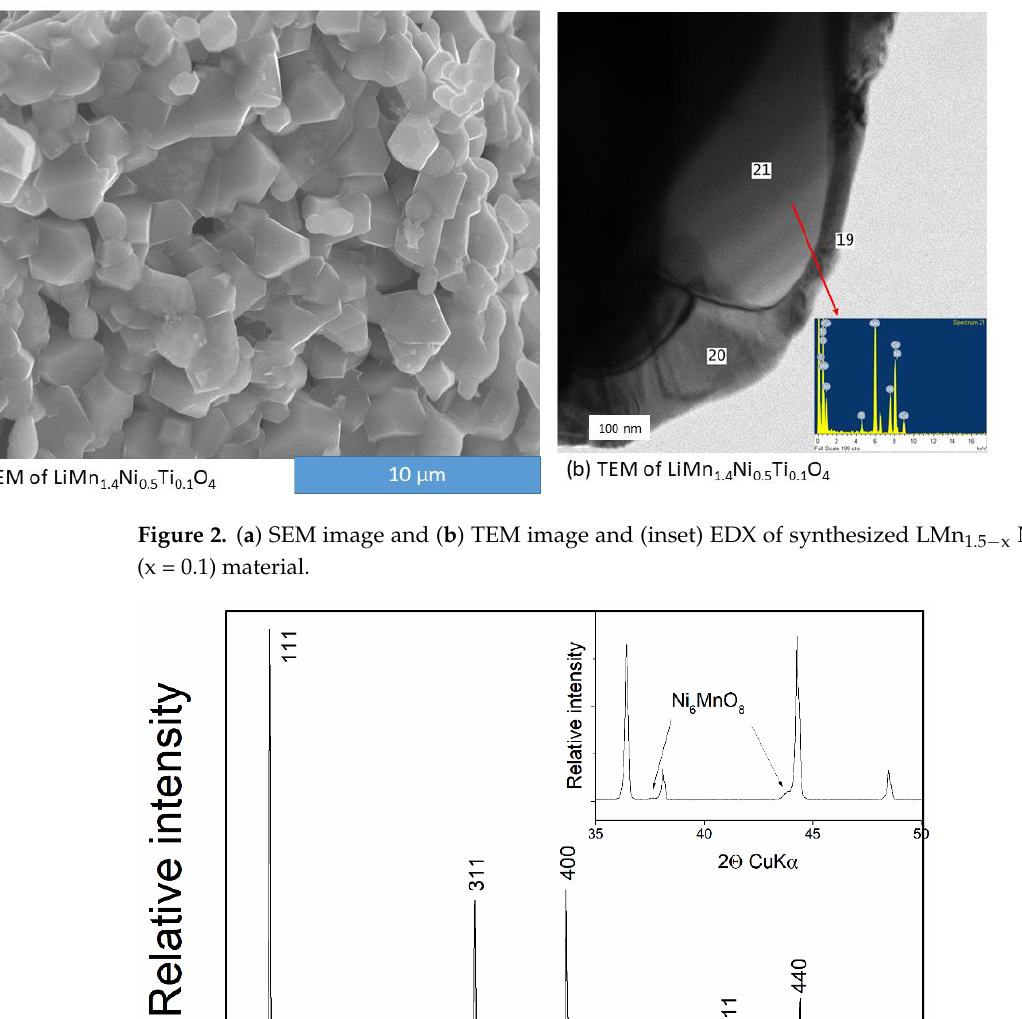
Figure 4. XRD patterns of synthesized LMNTO materials. Inset shows changes in lattice parameters as a function of substitution level. To obtain more insight on the effect of Ti 4+ ion on the chemical structure of LMNO, delithiated (50%) LiMn 1.4 Ni 0.5 Ti 0.1 O 4 was studied both in the bulk and at the surface by synchrotron X-ray microscopies at Ti L-edge, Ni L3- and oxygen K-edge. Figures 5 and 6